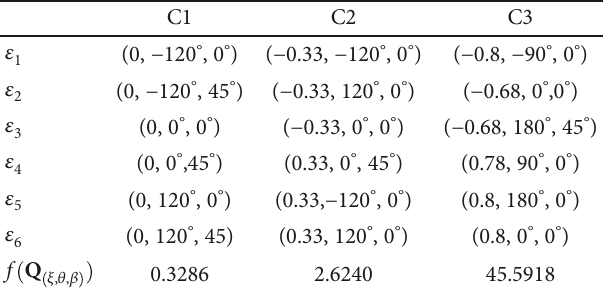
Table 1: Schemes of sensor placement. Each location was written as ξ , θ , β , i = 1, … , 6 . i i i